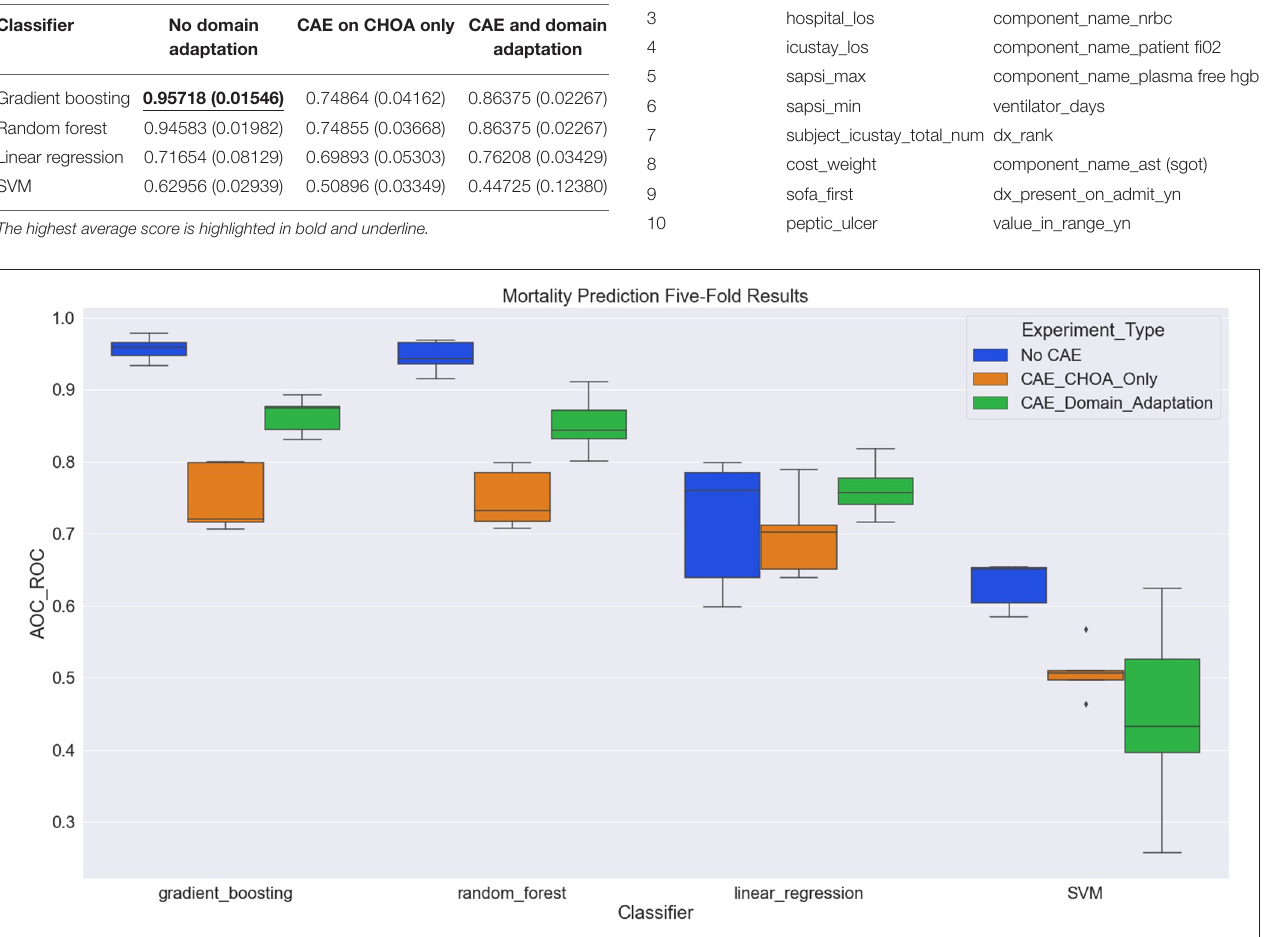
FIGURE 3 | Boxplot of mortality prediction results using four different classifiers with three experiment settings.